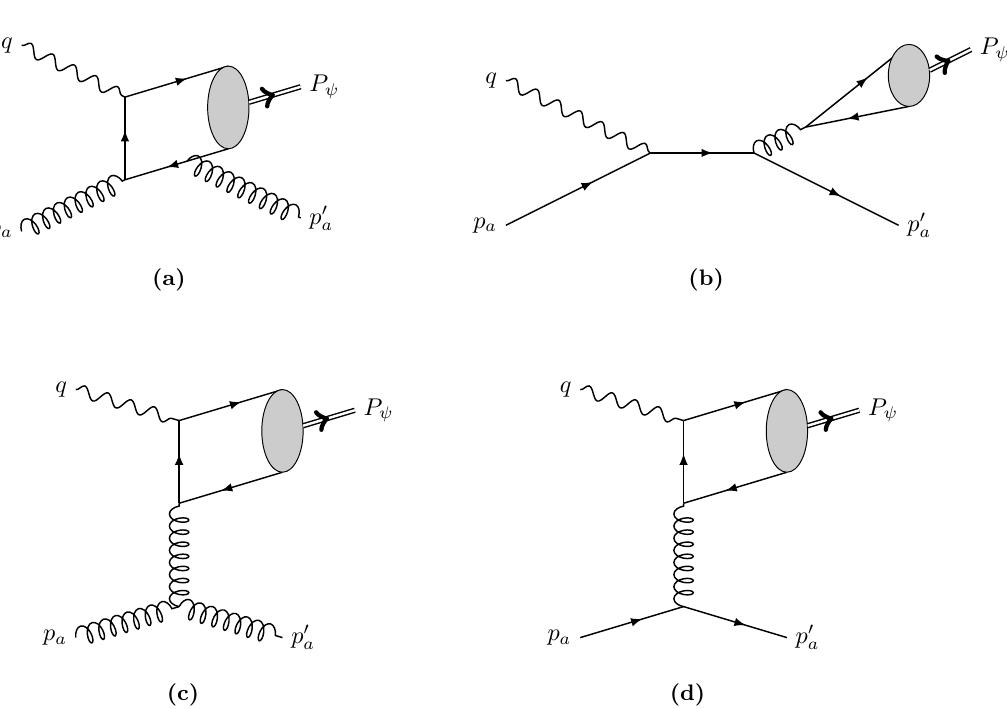
( q ) + a ( p ) ! J= ( P ) + a ( p ), (cid:3) 0 a a . The only diagrams contributing to the CS production mechanism s limit are those of type (c) and T